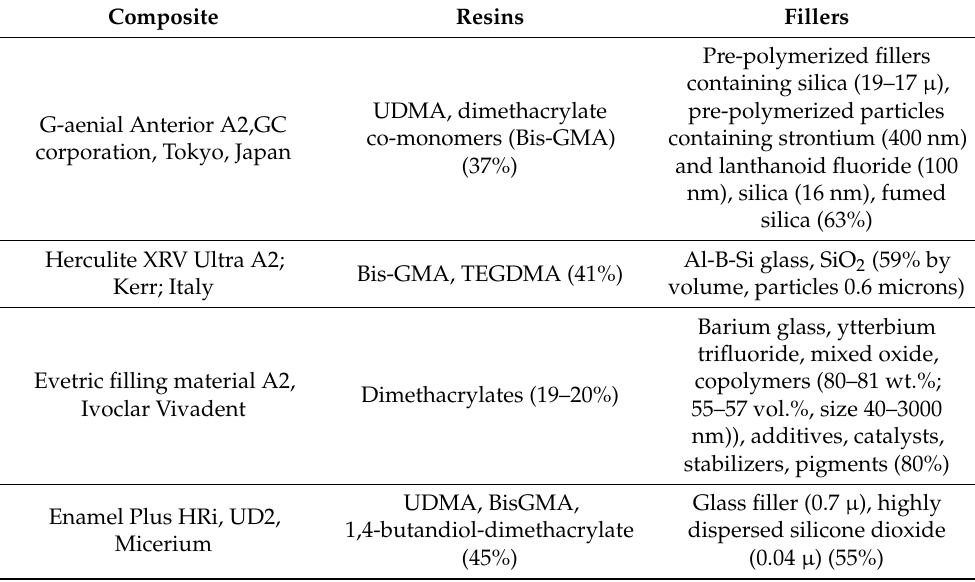
Table 1. Brand, manufacturer, composition of the RBCs brands